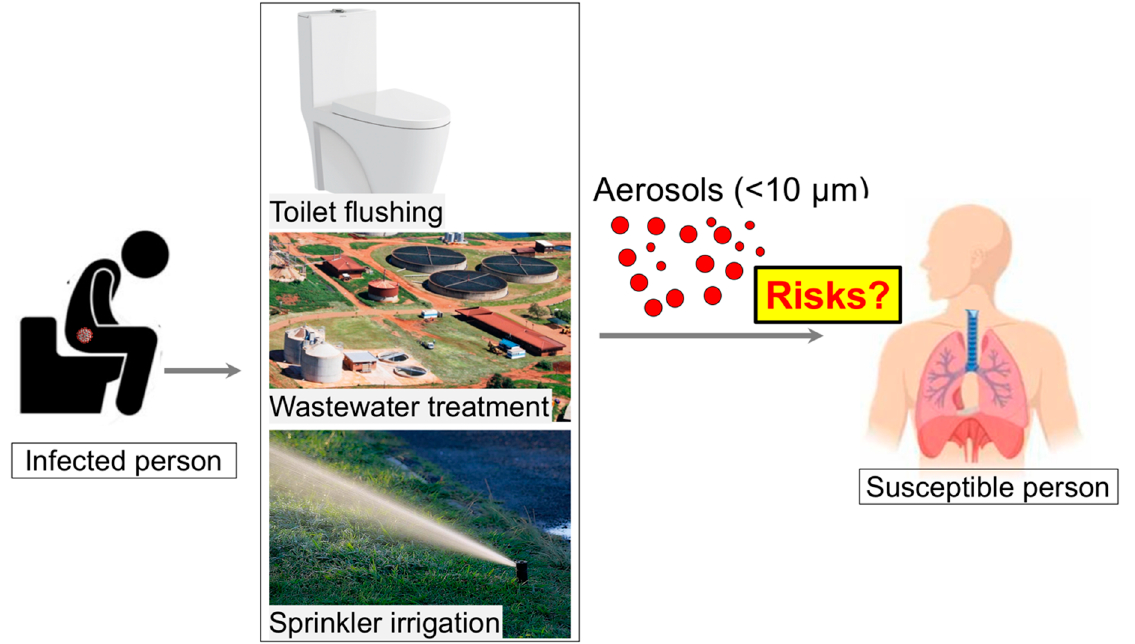
Figure 1. Overview of potential dissemination of SARS-CoV-2 (severe acute respiratory syndrome coronavirus 2) via aerosolized wastewater.